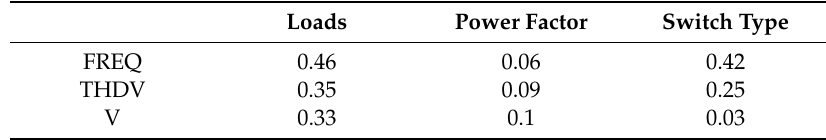
Table 7. Mutual information estimated among the appliance features and cluster labels derived from the PQ parameters measured at SoC 100%.